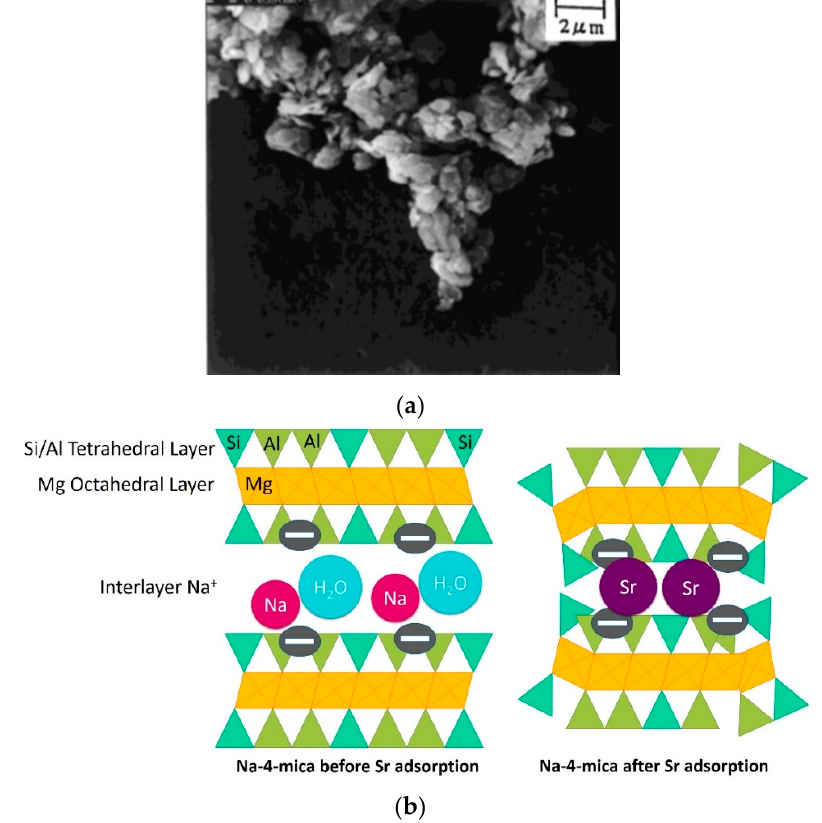
Figure 8. ( a ) SEM micrograph of Na-4-mica synthesized by Kodama et al. [104]; and ( b ) schematic illustration of Sr 2+ adsorption and immobilization by Na-4-mica. Reprinted with permission from reference [104].